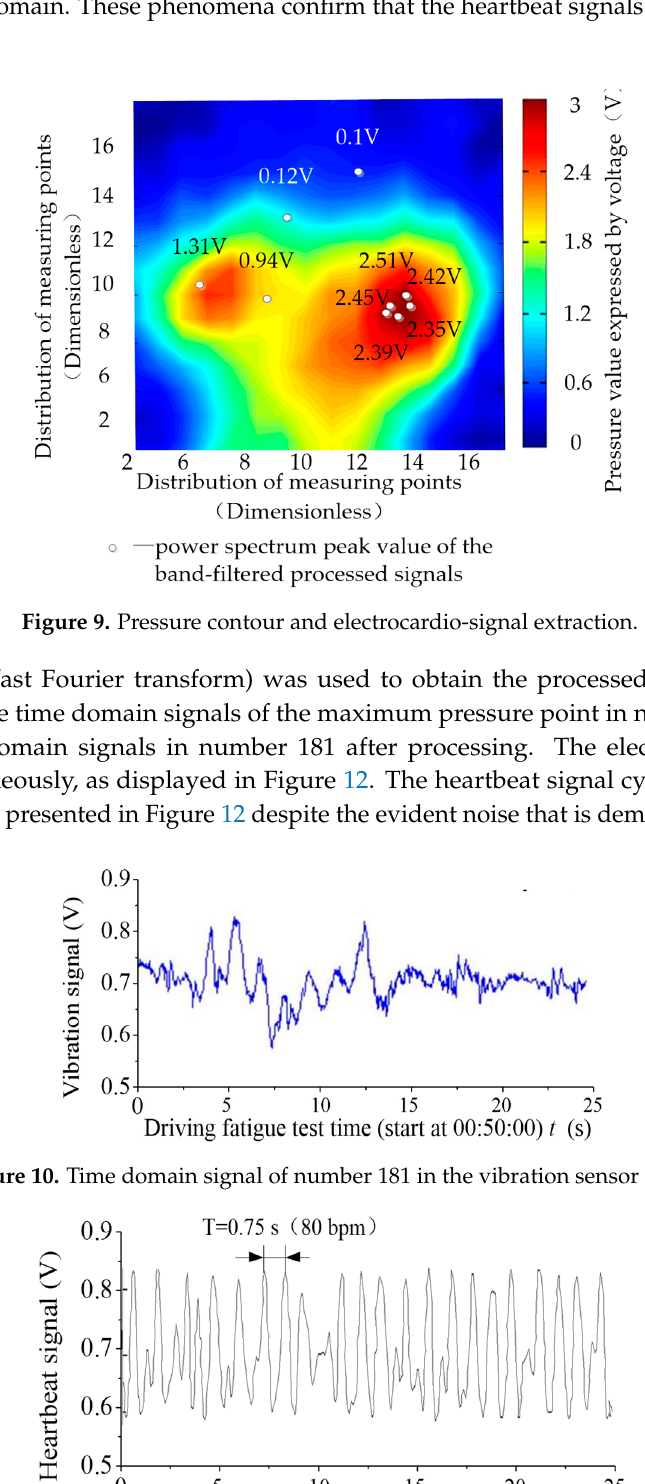
Figure 11. Extracted heartbeat signals of number 181 by noise reduction.